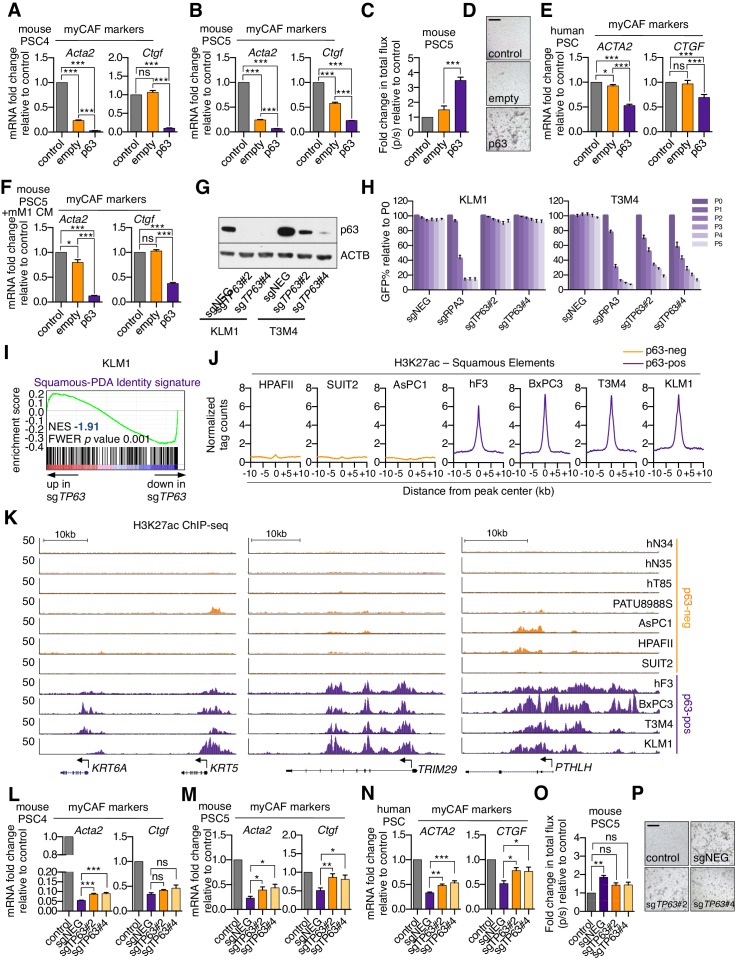
p63 expression in PDA cells drives a secretory phenotype that induces iCAF formation in vitro.(A–B) Bar charts showing RT-qPCR analysis for myCAF markers (Acta2, Ctgf) following culture of the two mouse PSC lines in Matrigel for four days with conditioned media from SUIT2-empty or SUIT2-p63 cells. (C) Luciferase-based quantification of mouse PSC proliferation in Matrigel. (D) Representative bright-field images from (C). Scale bar indicates 500 μm. (E) Bar charts showing RT-qPCR analysis for myCAF markers (ACTA2, CTGF) following culture of human PSCs in Matrigel for four days with conditioned media from SUIT2-empty or SUIT2-p63 cells. (F) Bar chart shows RT-qPCR analysis for myCAF markers (Acta2, Ctgf) following culture of mouse PSCs in conditioned media from mM1-empty or mM1-p63 cells. (G) Representative western blot analysis for ACTB and p63 following p63 knock out in KLM1-Cas9 and T3M4-Cas9 cells. (H) Competition based GFP depletion assays of KLM1-Cas9 cells (left panel) or T3M4-Cas9 cells (right panel) following infection with the indicated sgRNAs linked to GFP. (I) GSEA plot evaluating the Squamous-PDA Identity signature following doxycycline-inducible knock out of p63 and subsequent RNA-seq analysis KLM1 cells. The Squamous-PDA Identity signature was defined previously (Somerville et al., 2018). (J–K) Metagene representation (J) and browser track examples (K) of H3K27ac signal at Squamous Elements in p63-negative and p63-positive PDA cells. Normal organoids: hN34, hN35; PDA organoids: hF3, hT85; PATU: PATU8988S. (L–N) Bar charts showing RT-qPCR analysis for myCAF marker genes following culture of two mouse PSC cell lines (L and M) or human PSCs (N) in Matrigel for four days with conditioned media from KLM1-Cas9 cells infected with the indicated sgRNA. (O) Luciferase-based quantification of mouse PSC proliferation in Matrigel cultured with conditioned media from KLM1-Cas9 cells infected with sgRNAs targeting TP63 or control (sgNEG). (P) Representative bright-field images from (O). Scale bar indicates 500 μm. For all experiments control media represents DMEM supplemented with 5% FBS. Matrigel only represents conditioned media from Matrigel cultured with control media only. Mean+ SEM is shown. n = 3. For A, B, E and F, ***p<0.001, **p<0.01, *p<0.05 by Student’s t-test and for C, ***p<0.001, **p<0.01, *p<0.05 by one-way ANOVA with Dunnett’s test for multiple comparisons. ns, not significant.